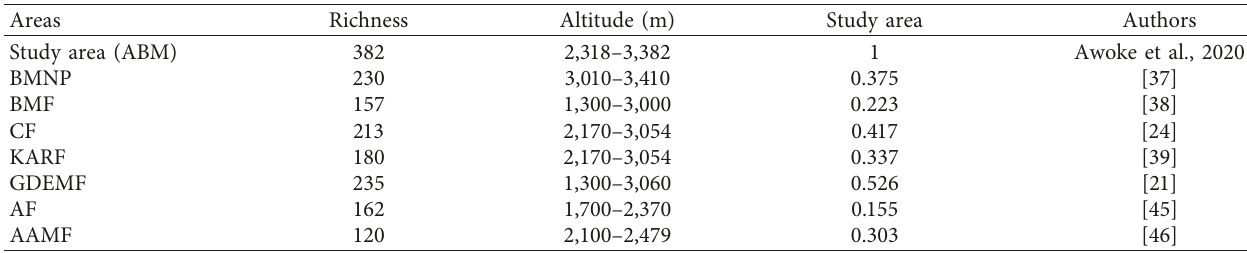
Table 7: Vascular plant species similarities between the present study area and other study areas in Ethiopia.